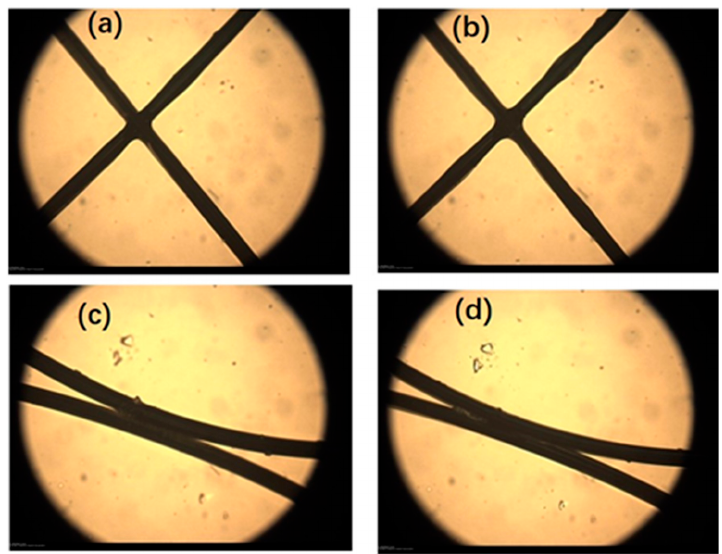
Figure 6. Possible mechanism of adhesion between PEBA and stainless steel wire by TPU